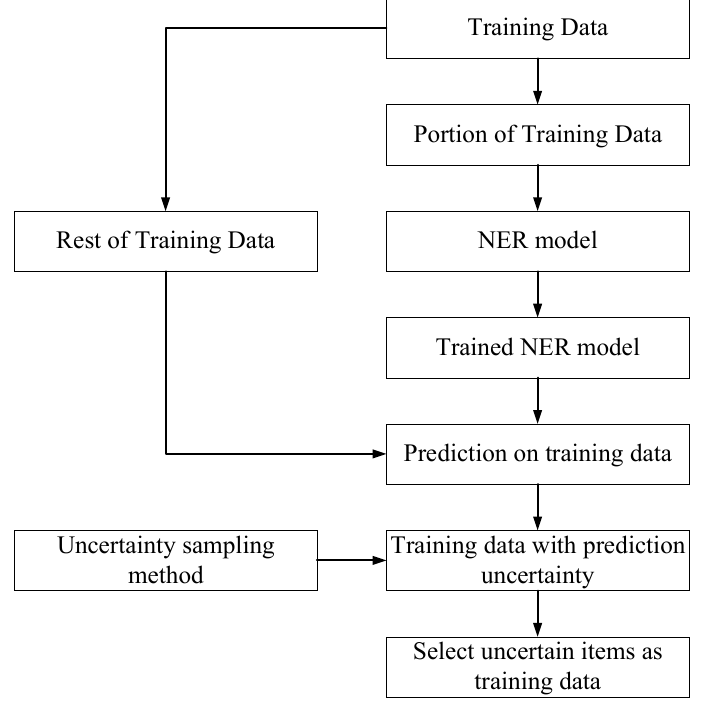
Figure 10. Uncertainty sampling method.